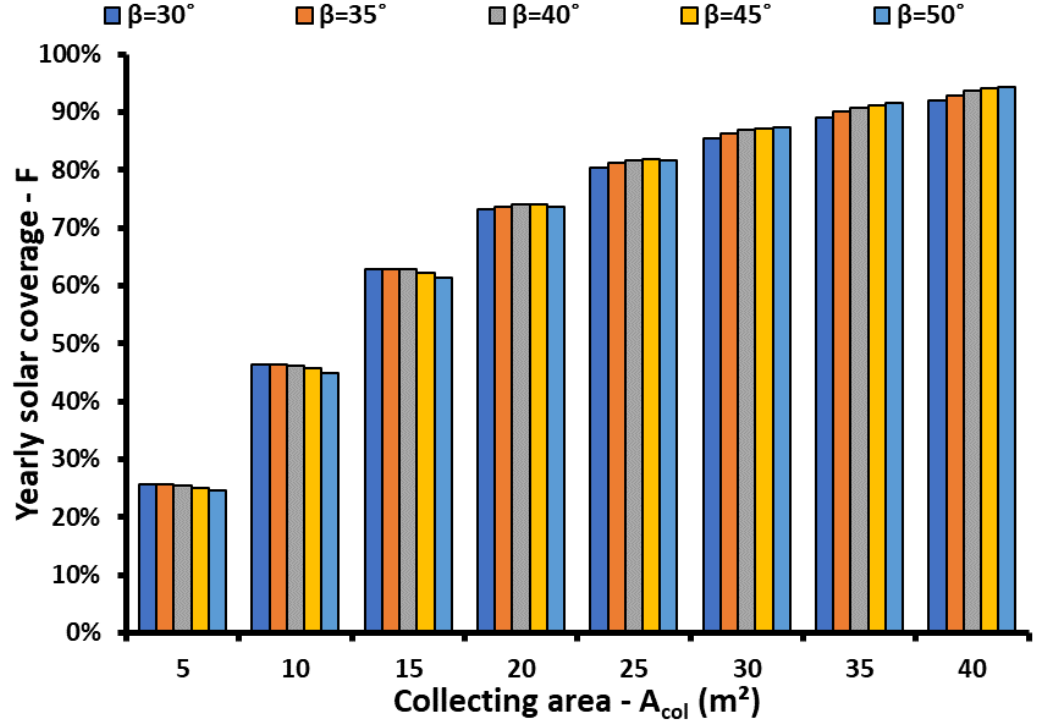
Figure 6. The impact of the solar field area and of the tilt angle on the yearly solar coverage for Athens and the ETC.